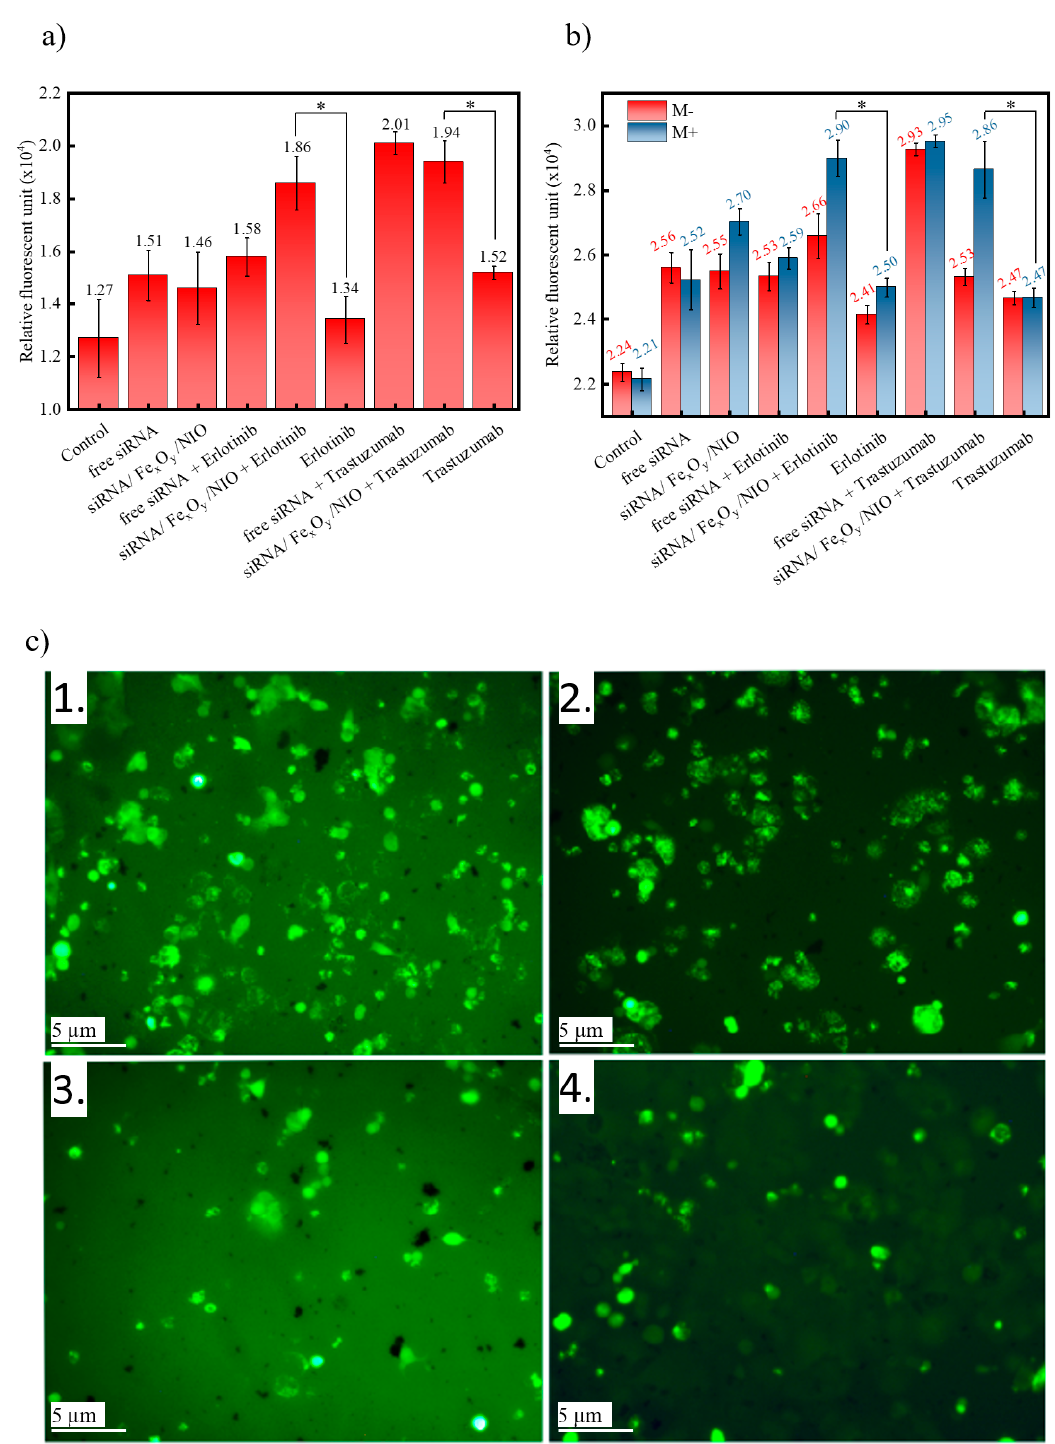
Figure 5. Apoptotic effect determined via ( a ) caspase 3/7 cleavage activity (without magnetic treatment) and ( b ) intracellular Ca 2+ concentration of free siRNA, siRNA/Fe x O y /NIO, free siRNA with anti-tumor agent, siRNA/Fe x O y /NIO with anti- tumor agent and free anti-tumor agent with (M+) and without (M-) magnetic treatment (* = the values of the samples containing siRNA/Fe x O y /NIO + anti-tumor agent and the value of the respective anti-tumor agent were analyzed using a t-test, with all data showing p < 0.05 considered significant); ( c ) representative fluorescent images (using the Calbryte-520 Assay Kit) showing occurring apoptosis (light green) of BT-474 cells after administration of ( 1 ) siRNA/Fe x O y /NIO with erlotinib, ( 2 ) free siRNA with erlotinib, ( 3 ) erlotinib and ( 4 ) control cells and a subsequent magnetic treatment.